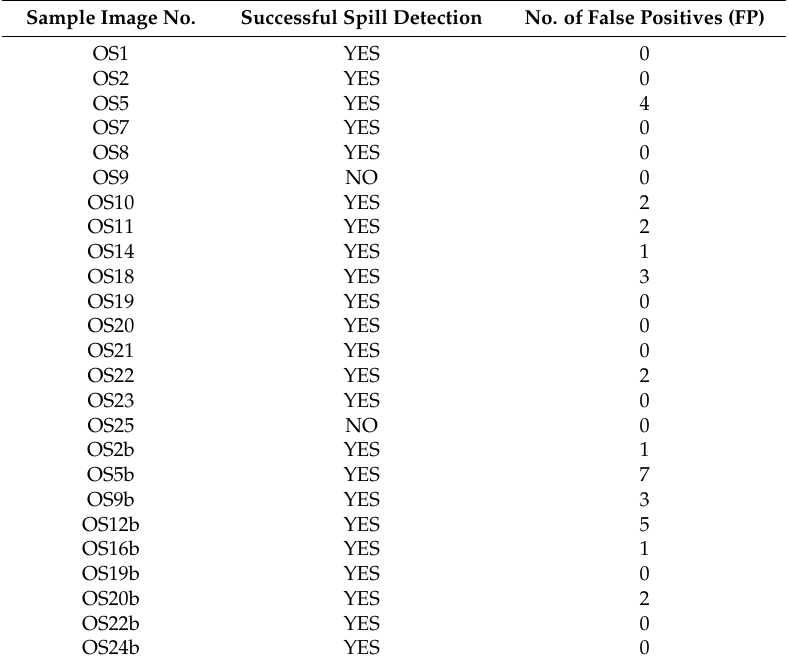
Table 1. Spill Detection Algorithm Results on Sample Images.